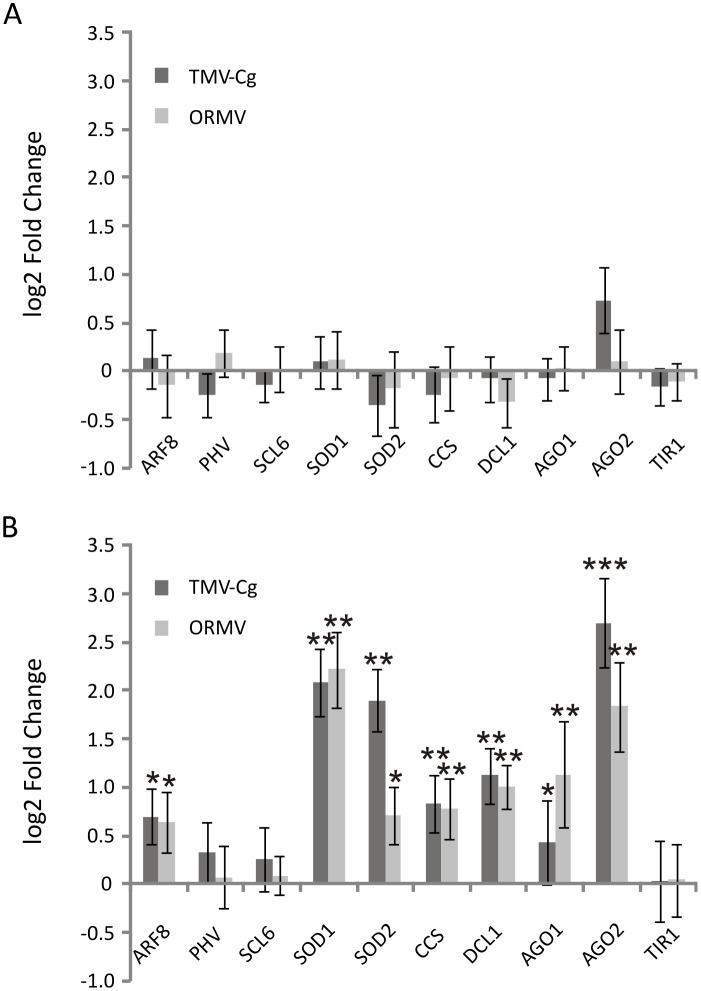
Quantitative RT-PCR analysis of selected miRNA target mRNAs upon tobamovirus infection at 2 and 4dpi.(A) Log2-fold change of miRNA target mRNA at 2dpi. Errors bars represent SE. (B) Log2-fold change of miRNA target mRNA at 4dpi. Errors bars represent SE. * = 0.01≤p≤0.05; ** = 0.001≤p≤0.01; *** = p≤0.001.